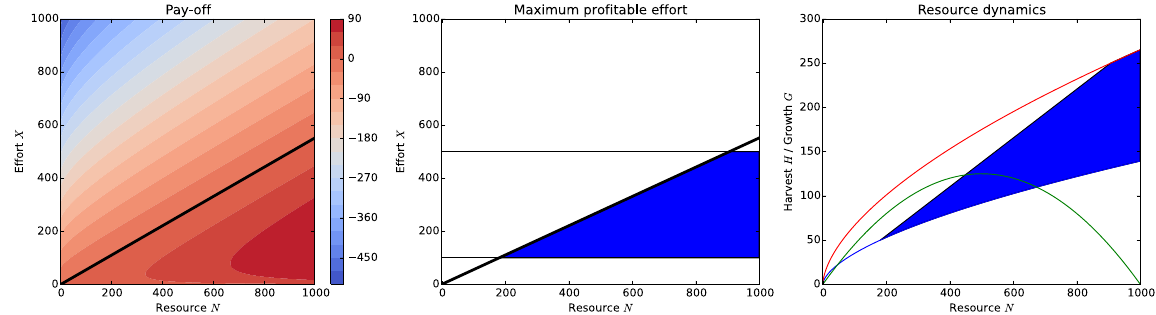
Figure 3. Profitable harvest (when cost c = 0.5). ( a ) Contour plot of cumulative profit H ( X , N ) − cX ; the black line indicates X maxprofitable , efforts above this line produce negative profit. ( b ) Profit with effort limits (thin black lines); the blue shaded area emphasises profitable effort levels at which the total profit H ( X , N ) − cX ≥ 0. ( c ) Resource dynamics with positive profits resulting from the profitable harvest efforts described in Fig. 3b indicated by the blue shaded